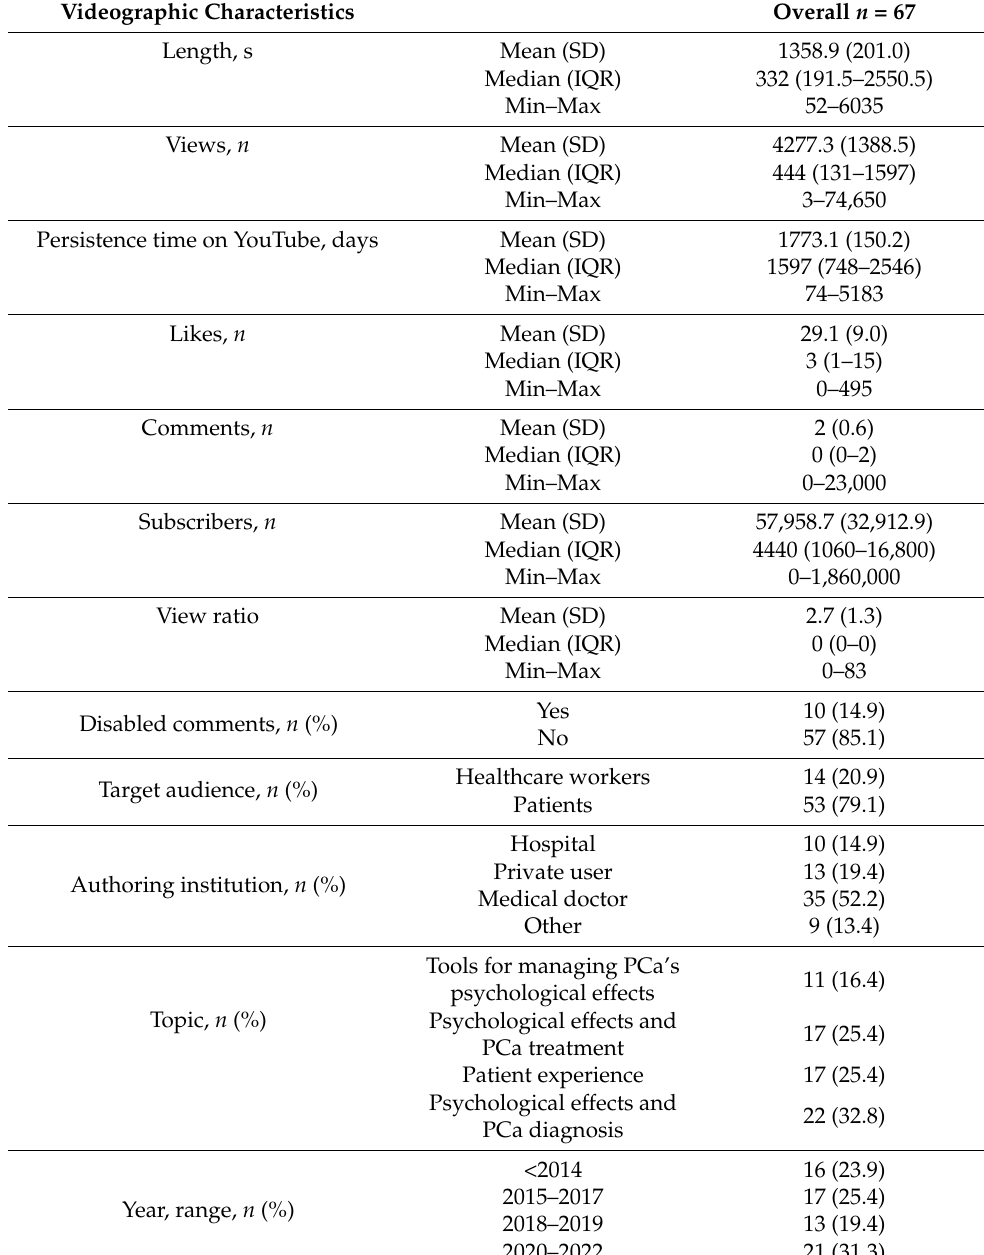
Table 1. Videographic characteristics of 67 YouTube TM videos on mental health of PCa patients selected on 18 May